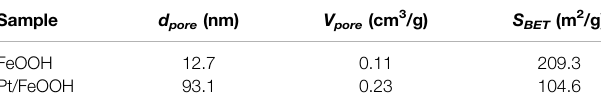
TABLE 1 | BET surface area, pore diameters, and pore volumes of samples.